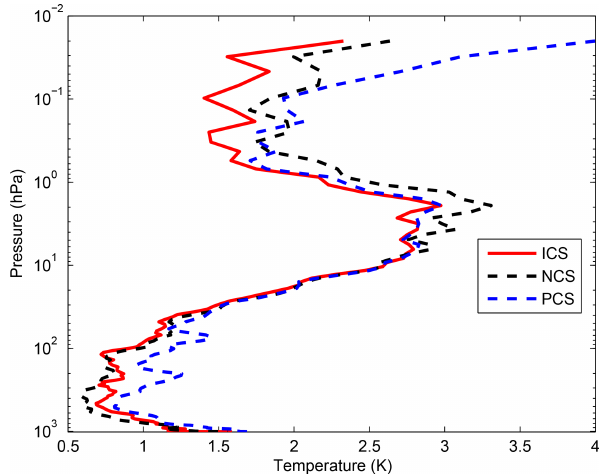
Figure 10. The average temperature profiles in four typical regions. The red line indicates the equatorial zone. The dashed pink line stands for the subtropics. The dashed blue line represents the mid- latitude region. The dashed black line stands for the